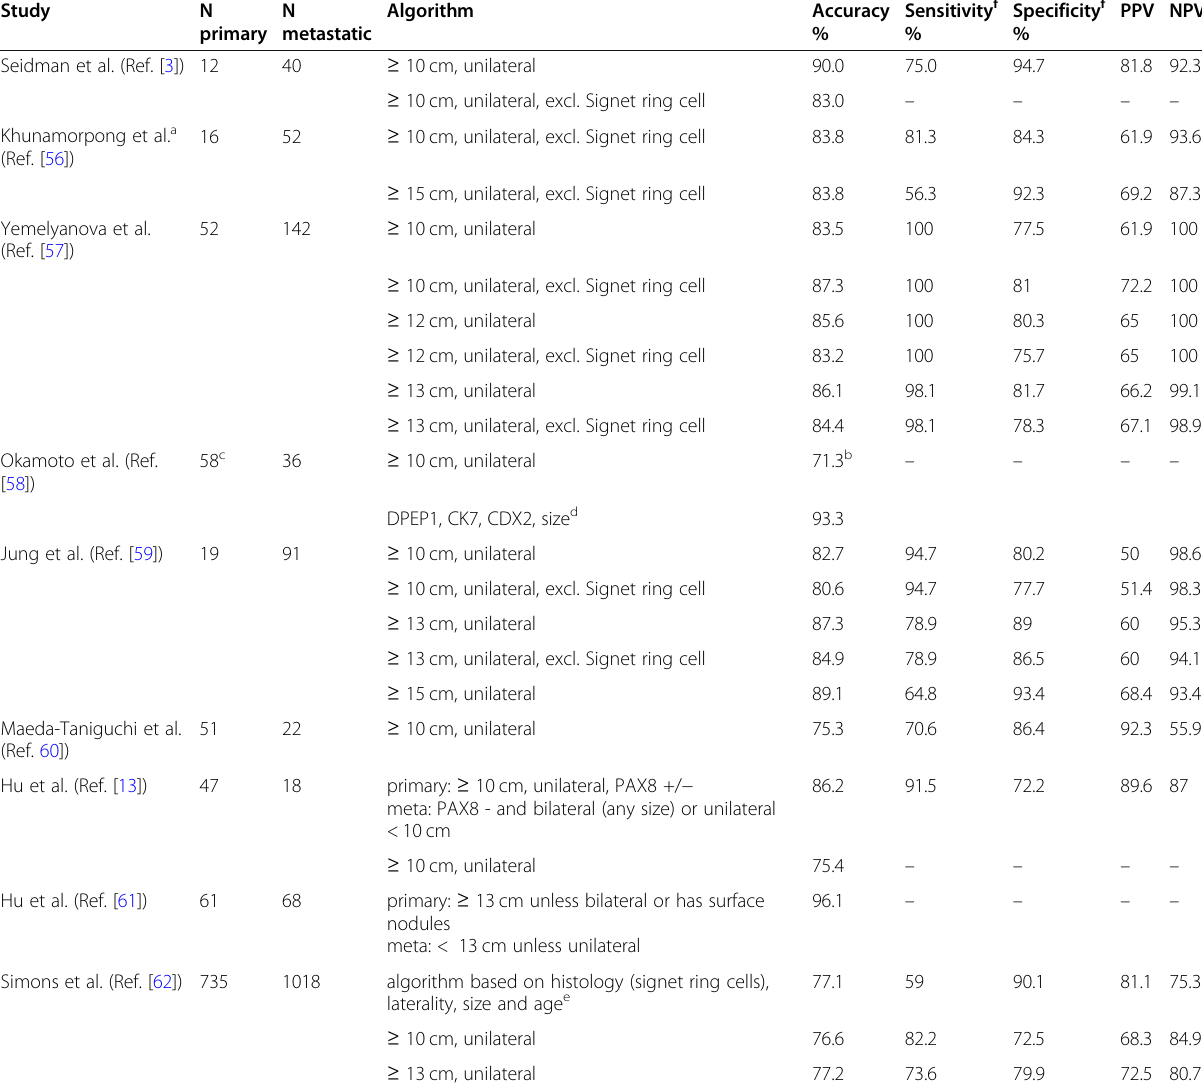
Table 3 Algorithmic approach to the differential diagnosis of ovarian mucinous tumors Study N N Algorithm primary metastatic